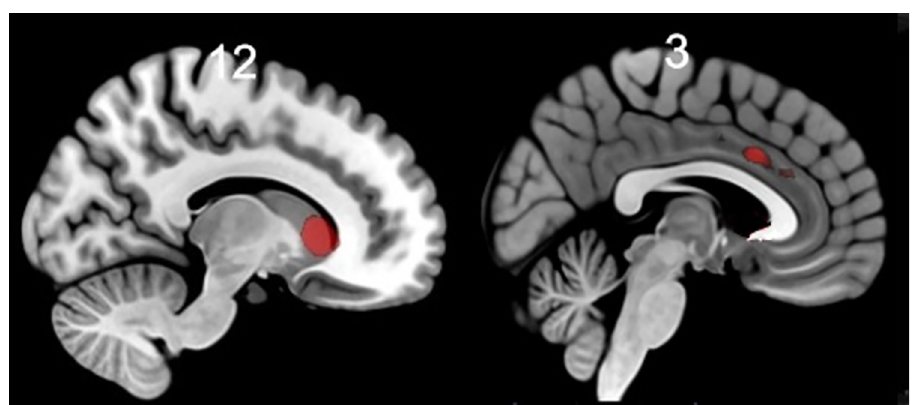
Fig 3. The association between pain anticipation and migraine frequency. Significantly activated cluster (caudate on the left and midcingulate on the right) is shown at pFWE < 0.05. Statistical map was visualized on the MNI 152 template brain provided in MRIcroGL (http://www.mccauslandcenter.sc.edu/mricrogl/) [58]. Coordinates are in Montreal Neurological Institute (MNI)